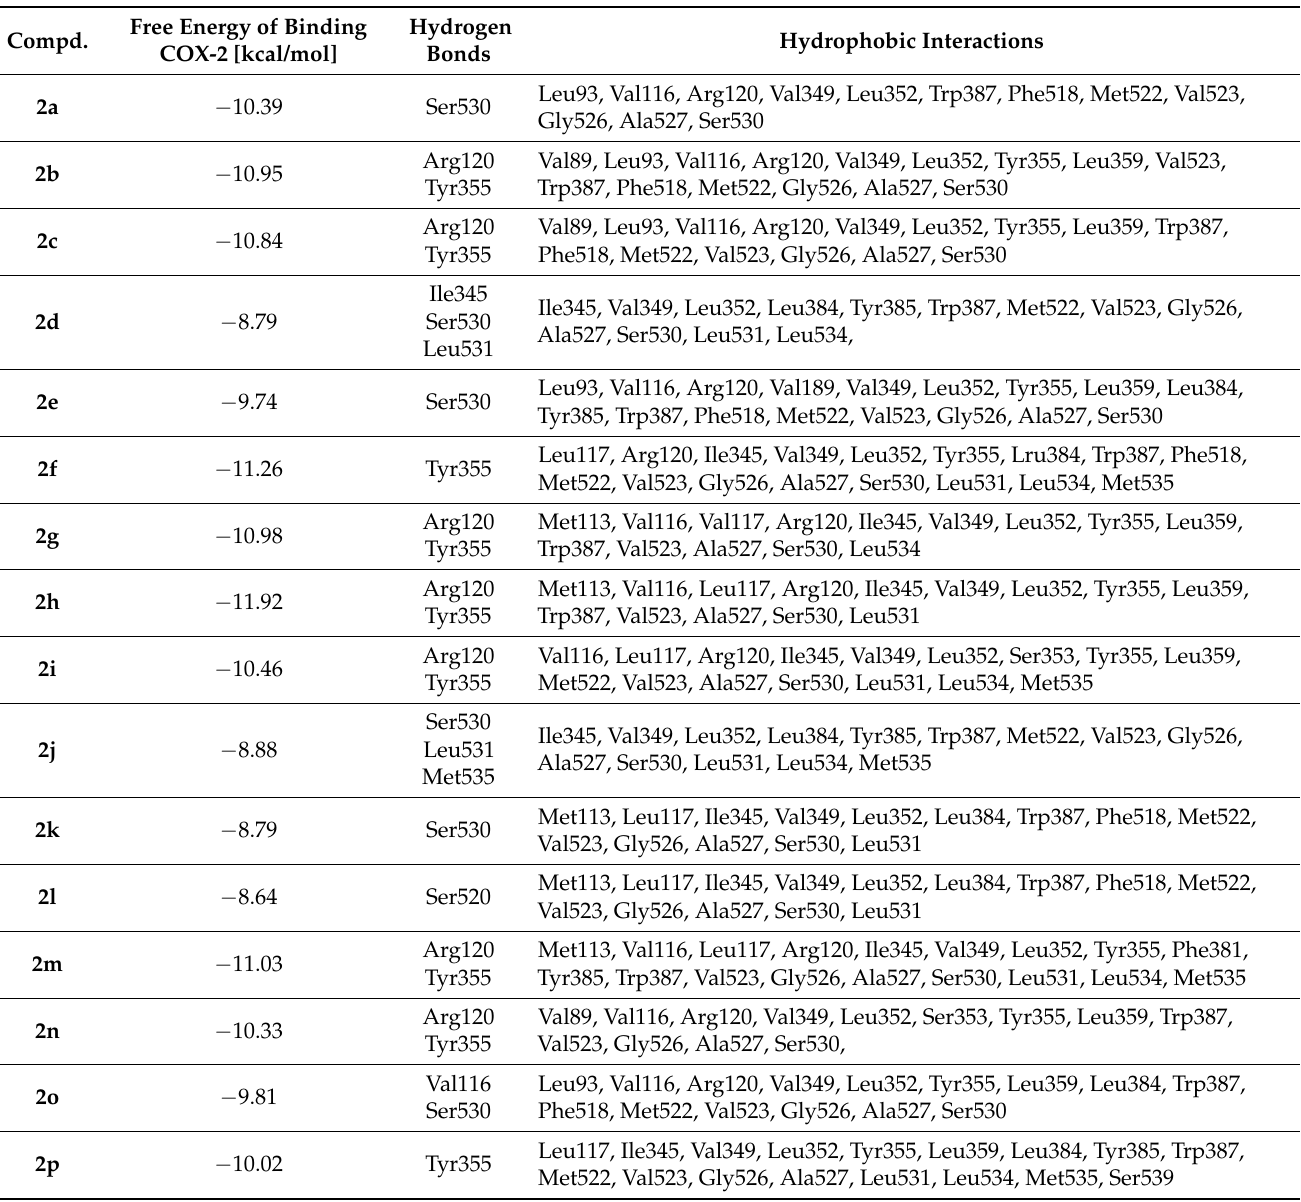
Table 5. Free energy of binding and binding mode of all considered compounds to COX-2.